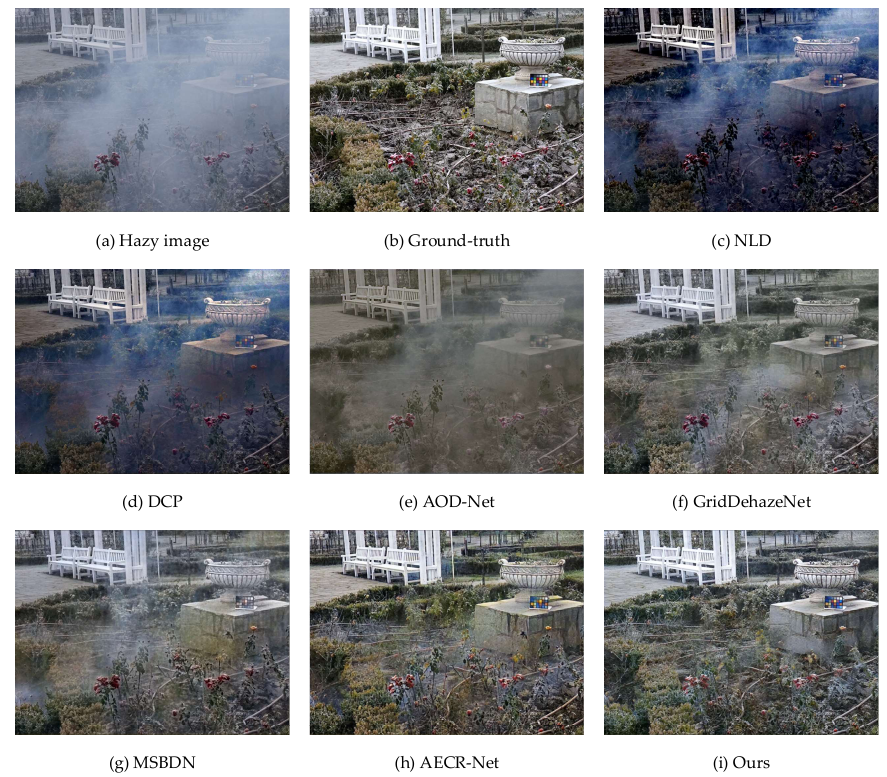
Figure 7. Visual quality comparison of NH-HAZE dataset.